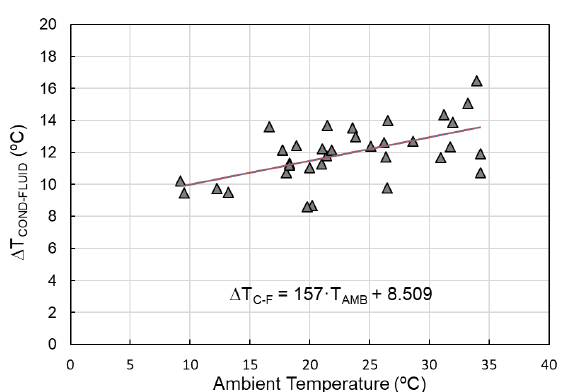
Figure 9. Temperature difference between the heat pump condenser ( T C ) and water in the tank ( T F ) vs. outdoor temperature ( T AMB ). Experimental measurements and